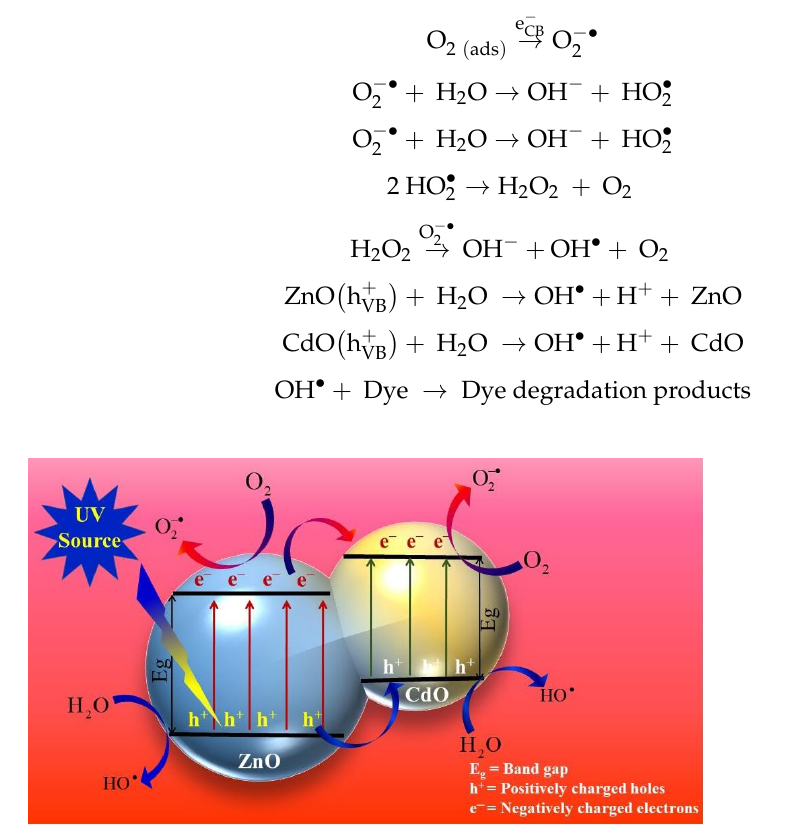
Figure 5. Proposed mechanism for RhB dye degradation with CdO-ZnO nanocomposites. Table 3. Comparison of photocatalytic degradation of RhB dye for CdO-ZnO nanocomposites, with previously reported photocatalysts.